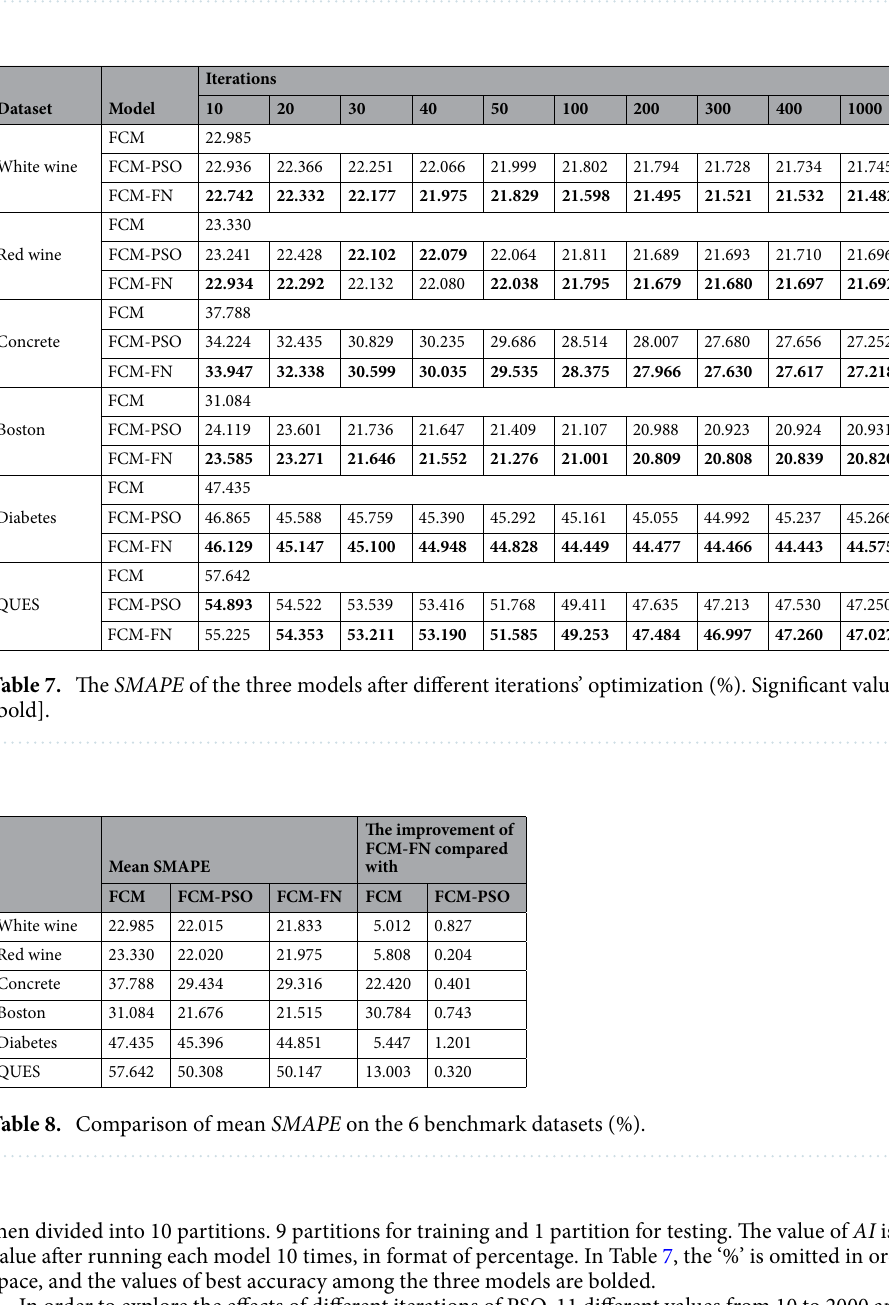
Table 6. Comparison of the performance (TI and PI).